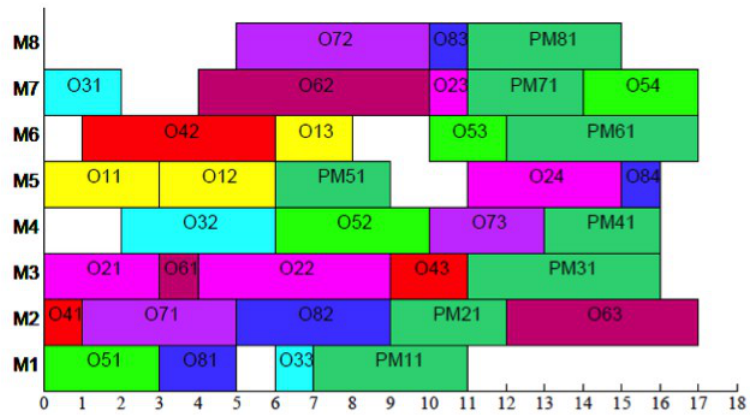
Figure 4. Gantt chart of best solution in